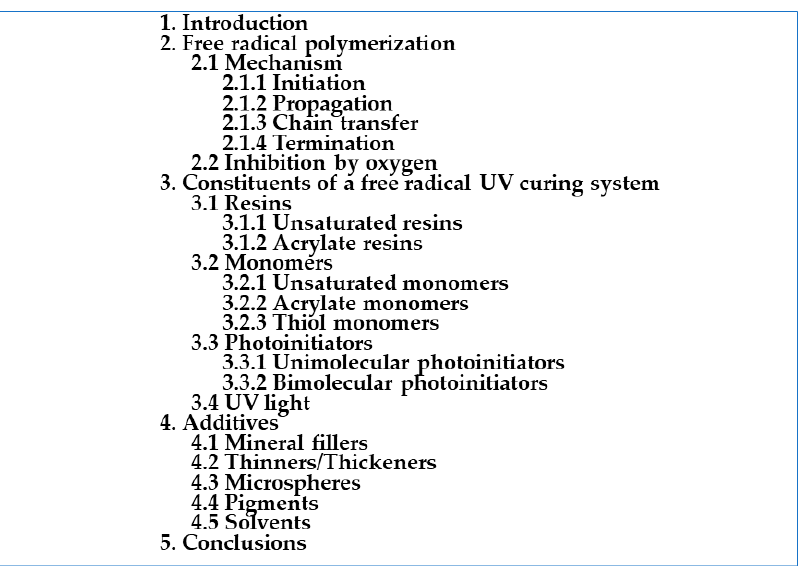
Chart 1. Schematic outline of the review on free radical photopolymerization for curing products.